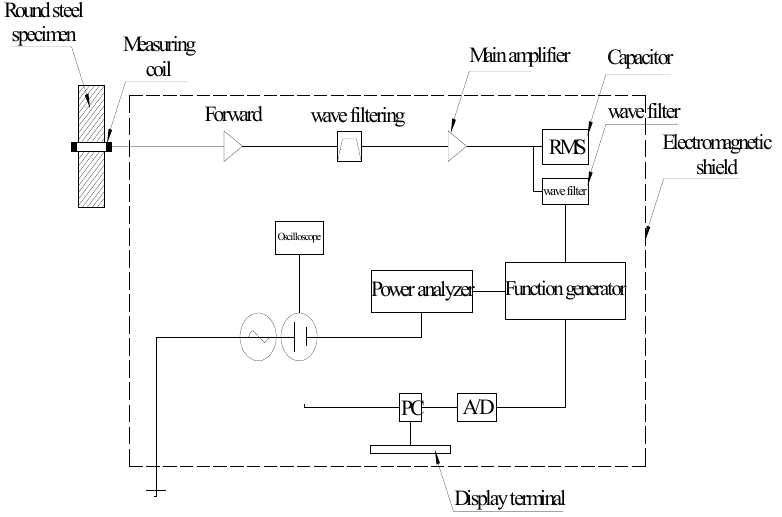
Figure 4. Main components of the magnetic flux sensing system.